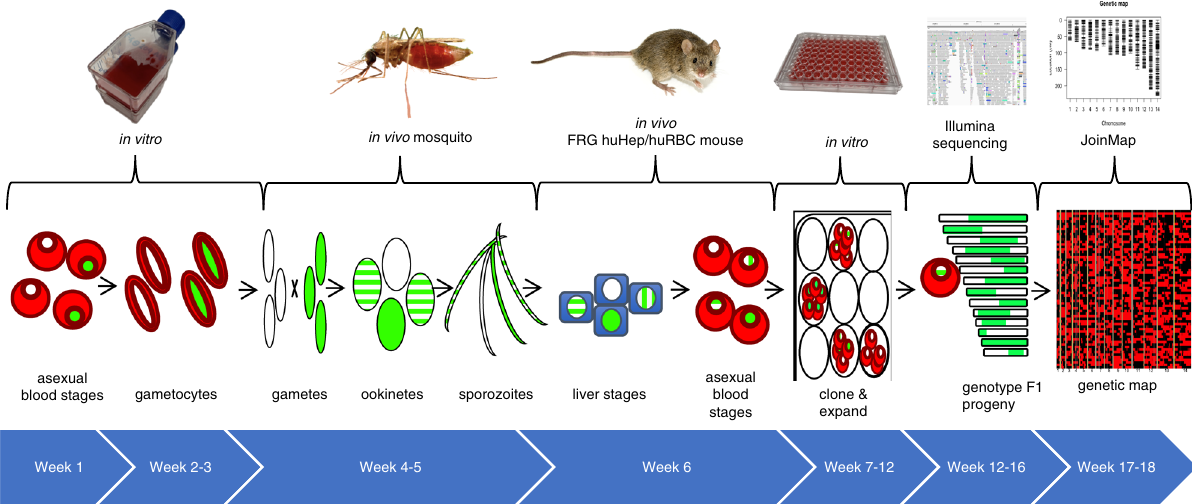
Fig. 1 Timeline for performing P. falciparum crosses in FRG NOD huHep/huRBC mice. Uncloned F 1 progeny from P. falciparum genetic crosses of recent fi eld isolates were recovered within 6 weeks from the start of the asexual stage culture of the two parent lines. Cloning of potential F takes an additional 6 weeks and next-generation sequencing of potential recombinant progeny and identi fi cation of unique recombinants via our pipeline takes an additional 6 weeks. This fi gure was adapted from Fig. 1a of Vaughan et al. 23 . The mosquito image was adapted from a photo created by James Gathany and the mouse image was created by George Shuklin both were made available for public use through creative commons lisences.